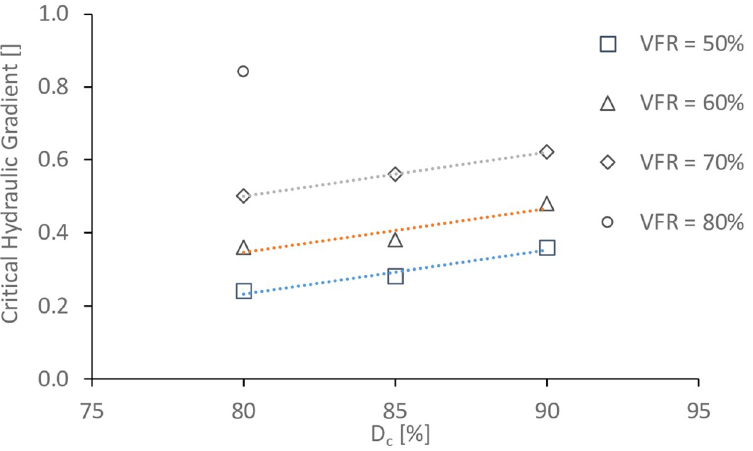
Fig 6. The effect of D c on the critical hydraulic gradient for specimens with different VFR.